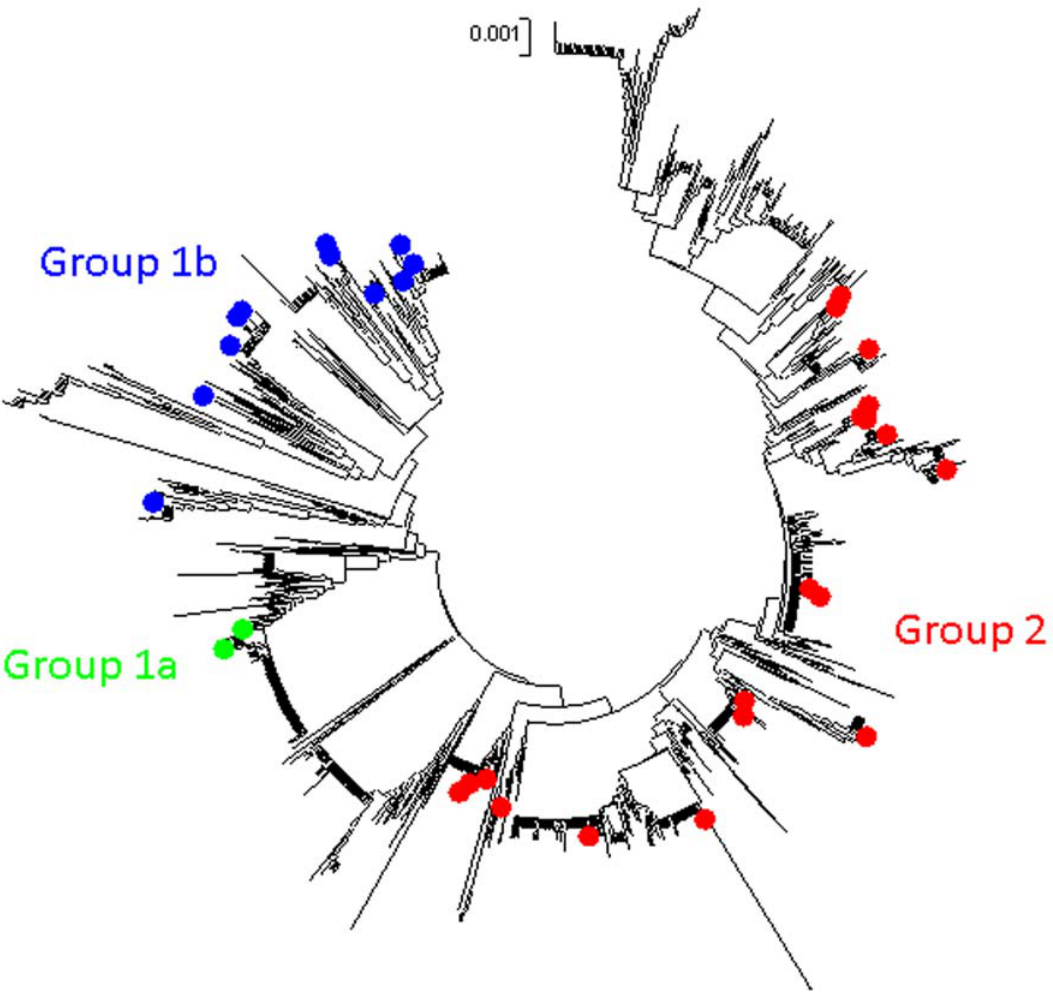
Figure 7. A neighbour-joining tree of 1294 STs from the MLST database with the STs in the Chengdu datasets highlighted. This confirms the cohesion of these three groups within the broad context of S. aureus